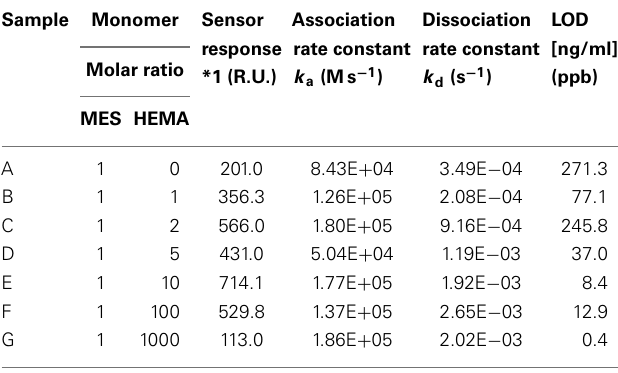
Table 2 | Kinetics parameters and the limit of detection (LOD); the LOD was calculated by considering three standard deviations at a 0ppb concentration ofTNT; sensor response *1: it was measured when the injection ofTNT solution was started